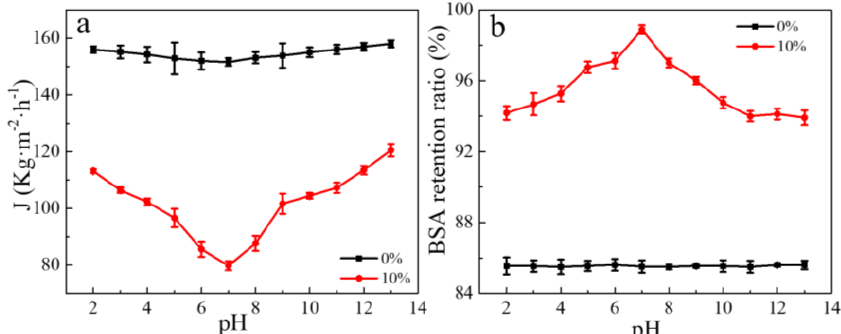
Figure 3. ( a ) Water fluxes at different pH values across pure ANF membranes and ANF/HANF membrane (HANF composition: 10 wt%). ( b ) BSA retention ratios at different pH values across pure ANF membranes and ANF/HANF membranes (HANF composition: 10